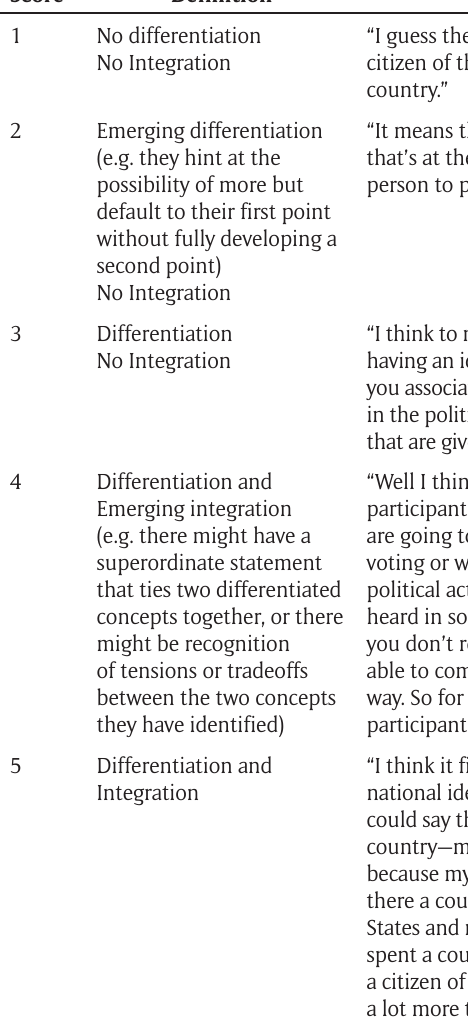
Table 1: Sample Responses for Integrative Complexity Score on “What does citizenship mean to you?”